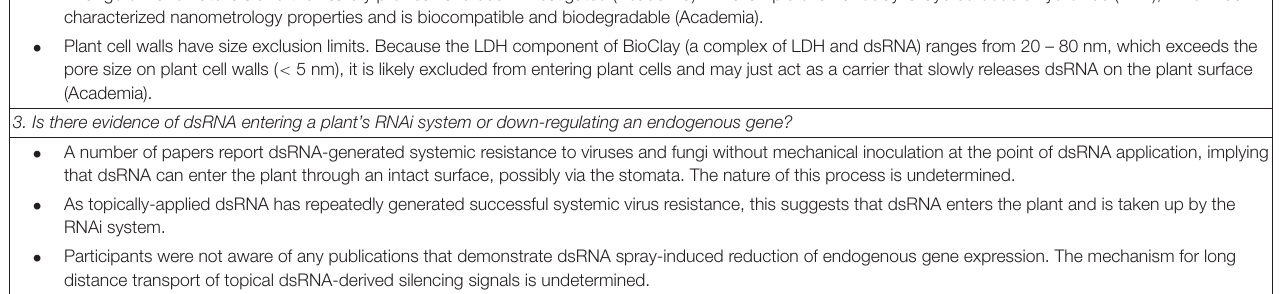
TABLE 2 | Comparison of comments on testing for environmental assessments from various governmental or multi-governmental bodies. European Union (Two step